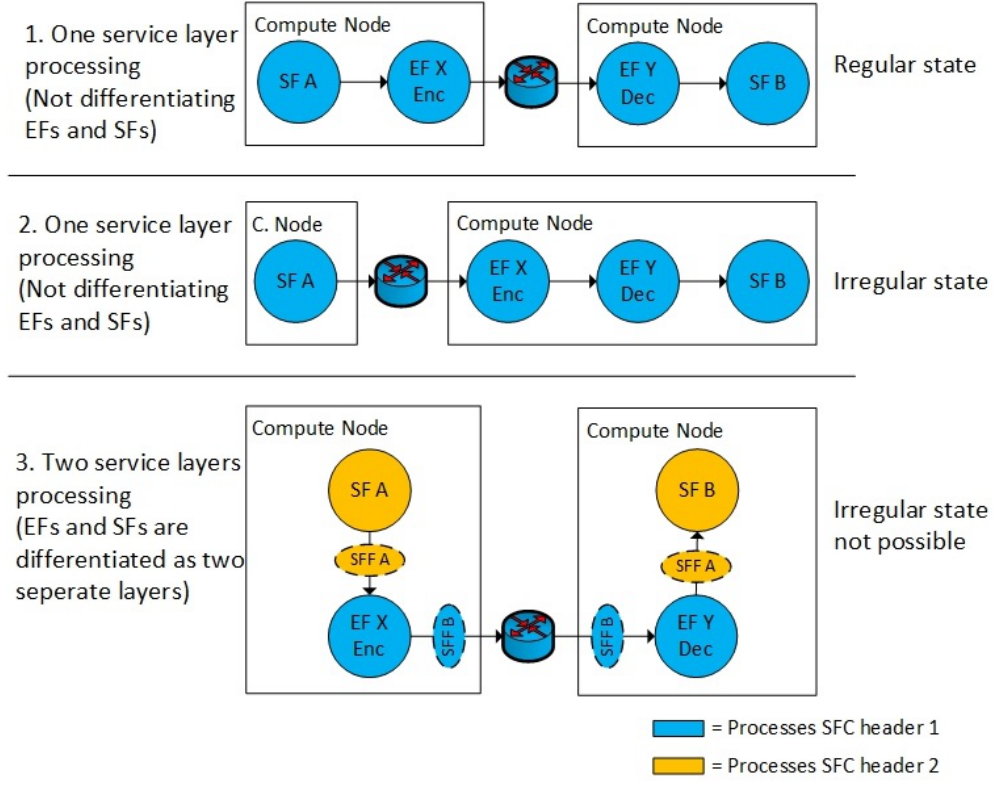
Figure 5. An additional encryption